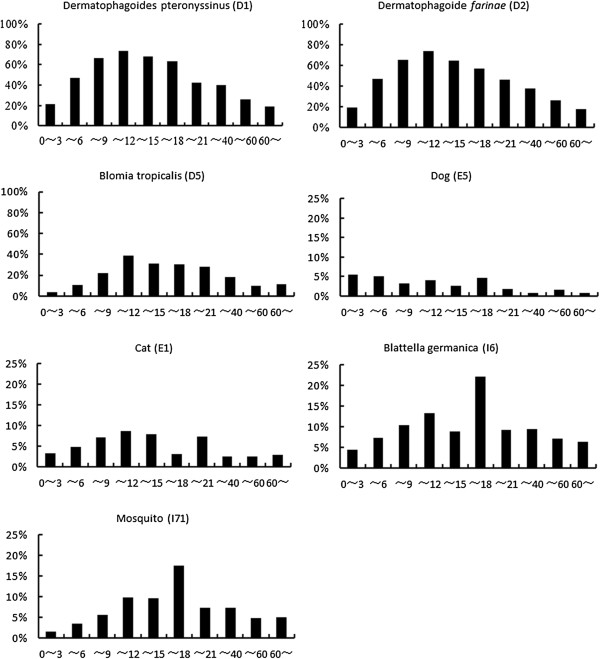
Positive rates of sIgE to aeroallergens in all age groups. The total number of cases in each age group: age 0–3 (n = 2695), 4–6 (n = 1887), 7–9 (n = 543), 10–12 (n = 314), 13–15 (n = 113), 16–18 (n = 63), 19–21 (n = 54), 22–40 (n = 683), 41–60 (n = 555), > 60 (n = 140).